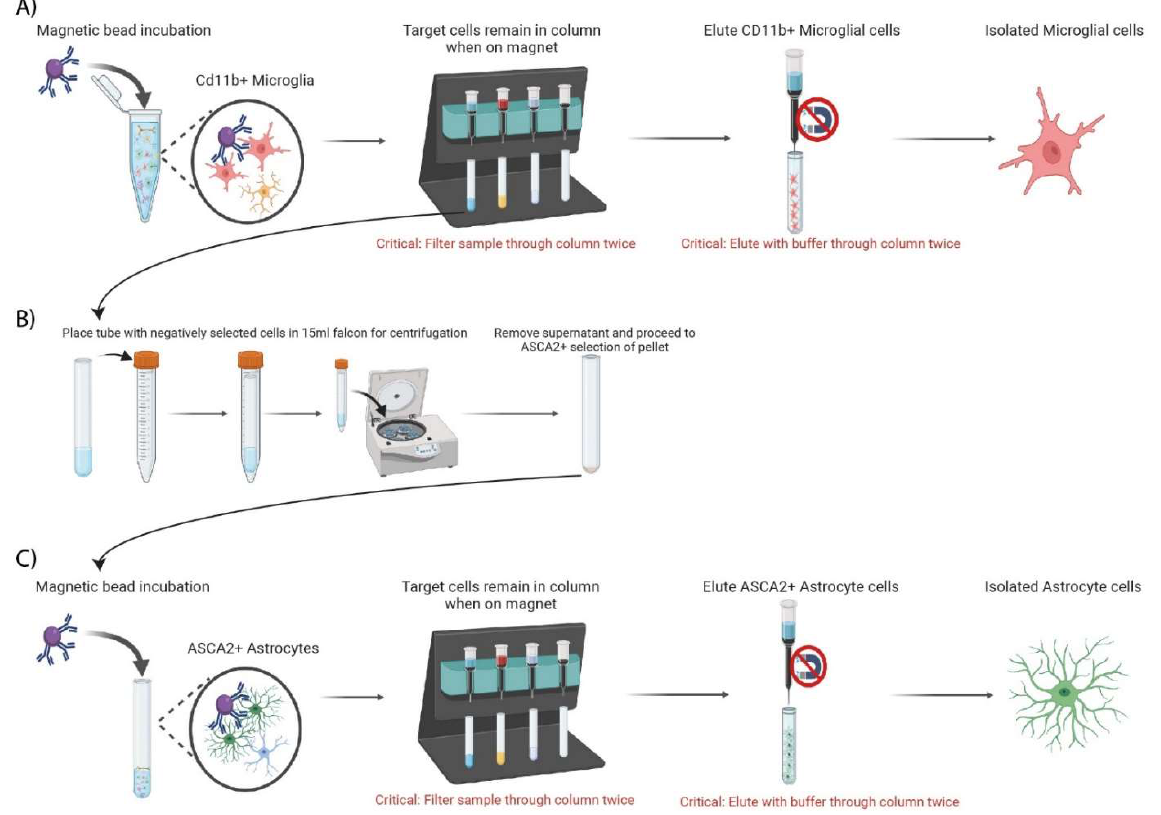
Figure 4. Schematic workflow of magnetic labeling for the sequential isolation of microglia and astro- cytes. Following brain dissociation, debris, and red blood cell removal, ( A ) the purified homogenate is incubated with magnetically labelled anti-CD11b microbeads. Homogenate is then twice filtered through MS columns whilst attached to magnet. CD11b positively selected cells remain in the column and are then eluted into a fresh tube for microglial specific RNA extraction. The negative flow-through is collected for further processing. ( B ) Washed sample in negative flow-through columns are placed in 15 mL falcons to allow for centrifugation of cell pellet. Following centrifugation, supernatant is removed and pellet is processed for astrocyte isolation. ( C ) Sample incubated with anti-ACSA-2 microbeads, before astrocyte isolation and elution as described in ( A